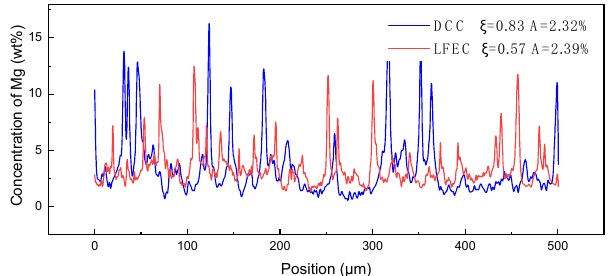
Figure 10. Concentration of Mg detected by EPMA along the line in Figure 9a,c.